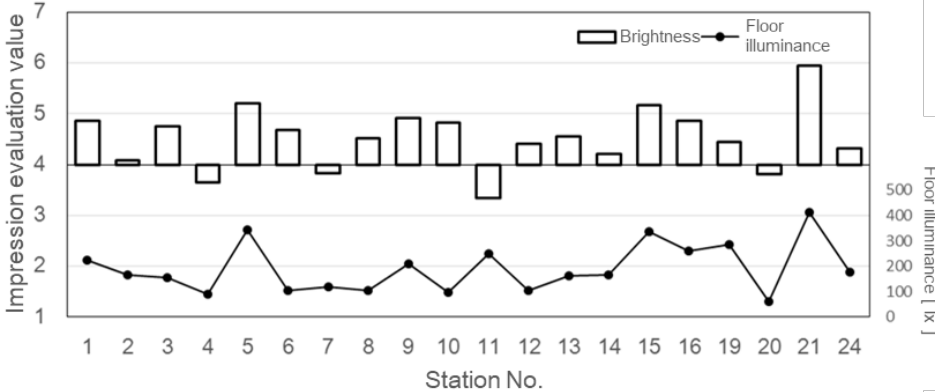
Figure 12. Results of impression evaluation of brightness and floor illuminance.